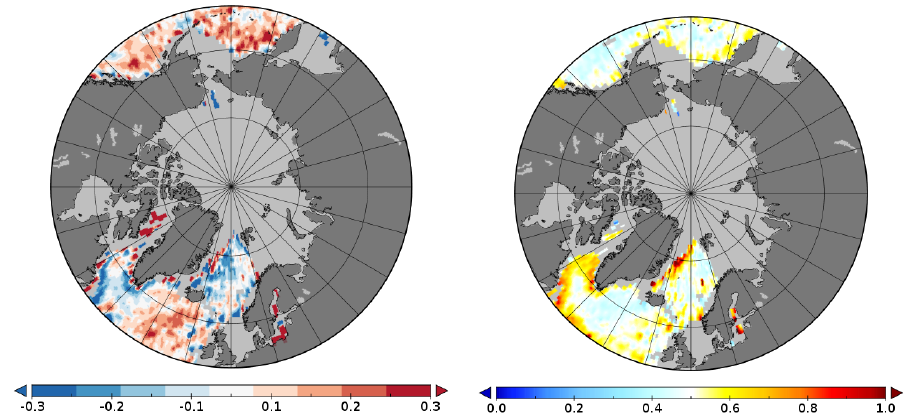
Figure 5. Spatial distributions of the differences between SMOS and Argo SSS: ( Left ) the mean of SMOS-Argo SSS; and ( Right ) the std of the difference.